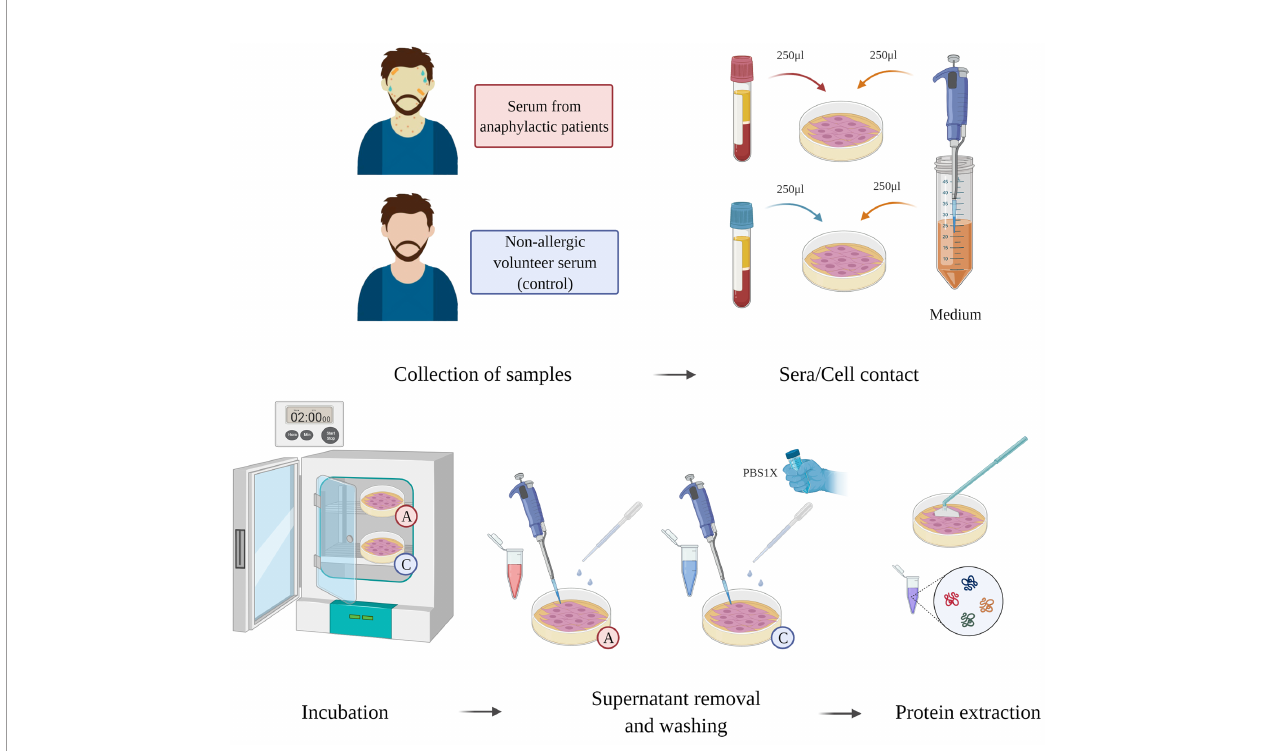
FIGURE 1 | Sera-EC systems work fl ow. ECs were incubated together sera from anaphylactic patients (n = 5) or sera from control subjects (n = 5) during for 2 hours. Supernatant was then removed; the ECs were washed and then an ECs protein extraction was